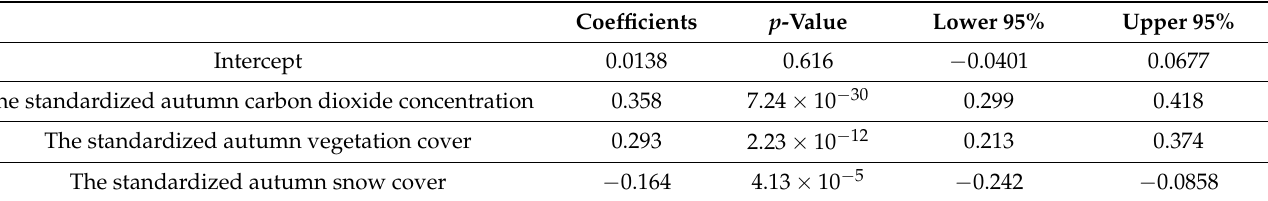
Table 10. T -test for each parameter (autumn).